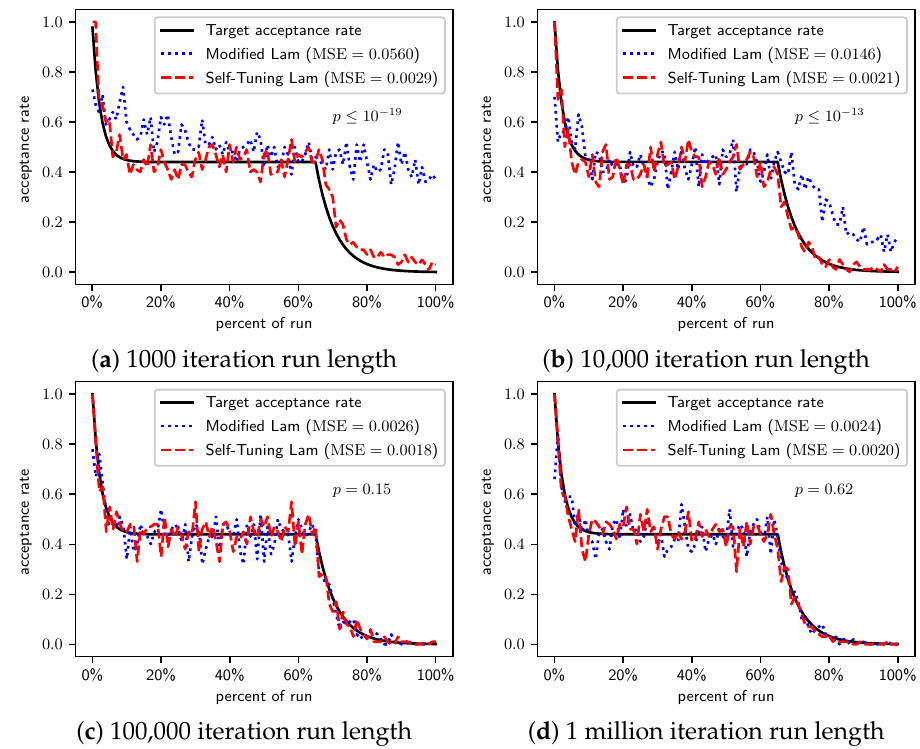
Figure 8. Minimize f 1,1 ( x ) : Self-Tuning Lam, Modified Lam, and target acceptance rates for ( a ) 1000 it- erations, ( b ) 10,000 iterations, ( c ) 100,000 iterations, and ( d ) 1 million